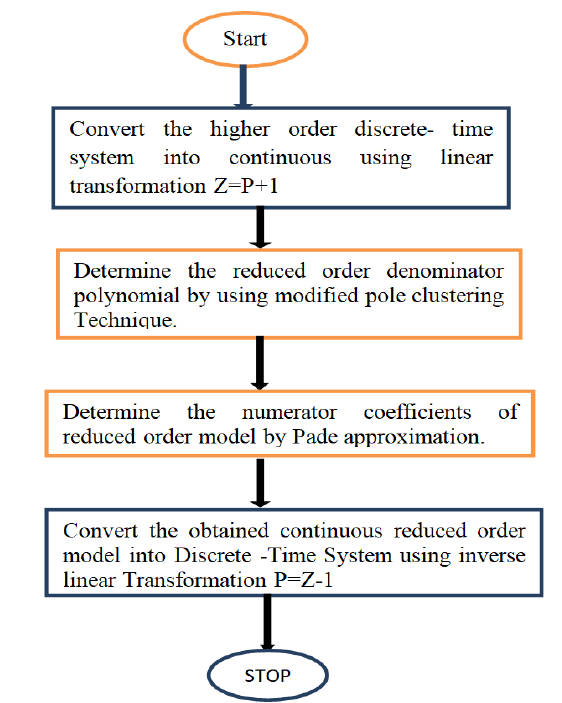
Figure 1. Flow chart of step wise procedure for